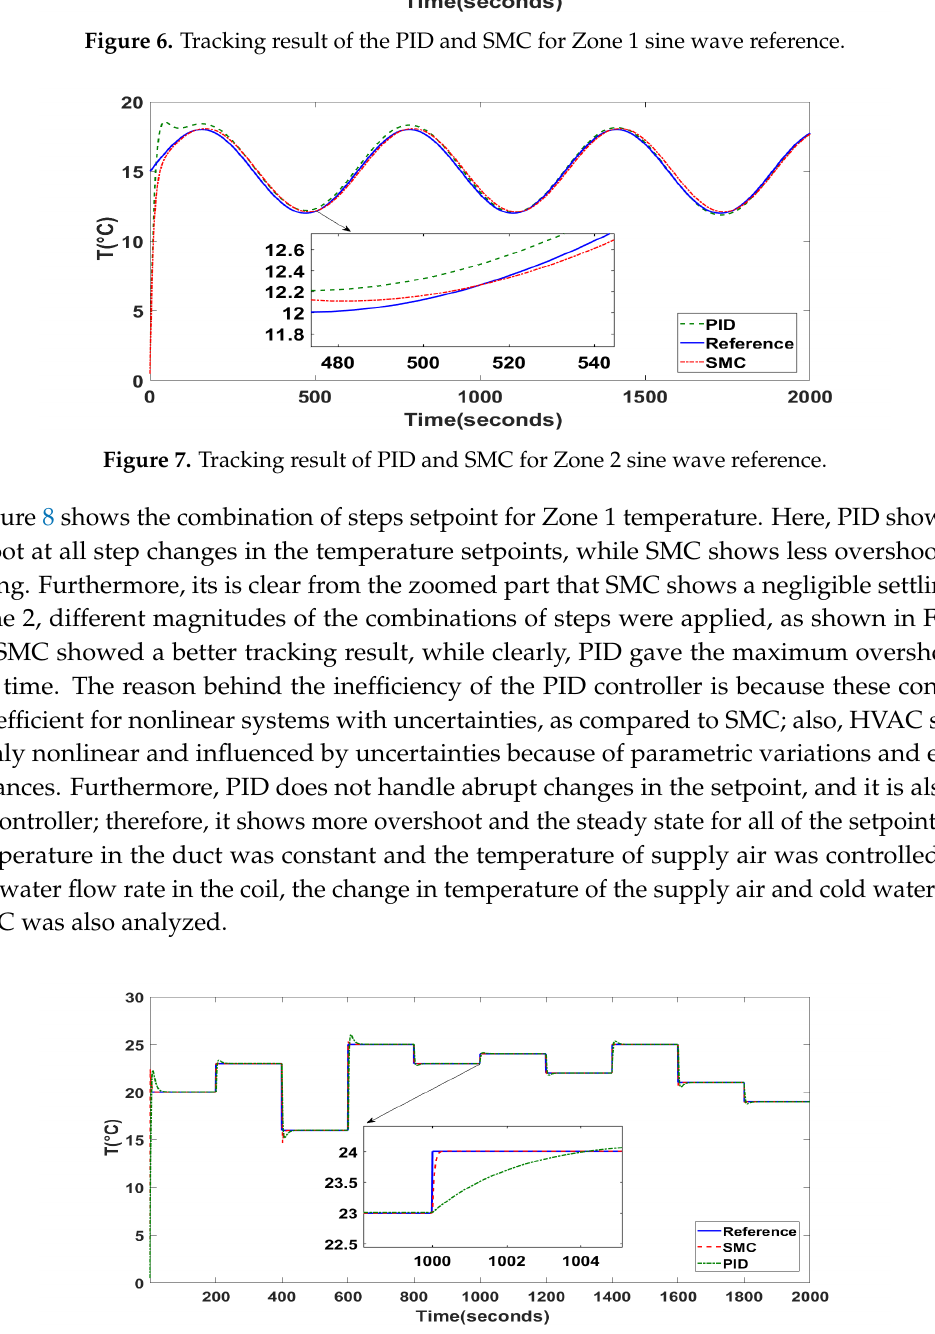
Figure 8. Tracking result of PID and SMC for the Zone 1 combination of steps